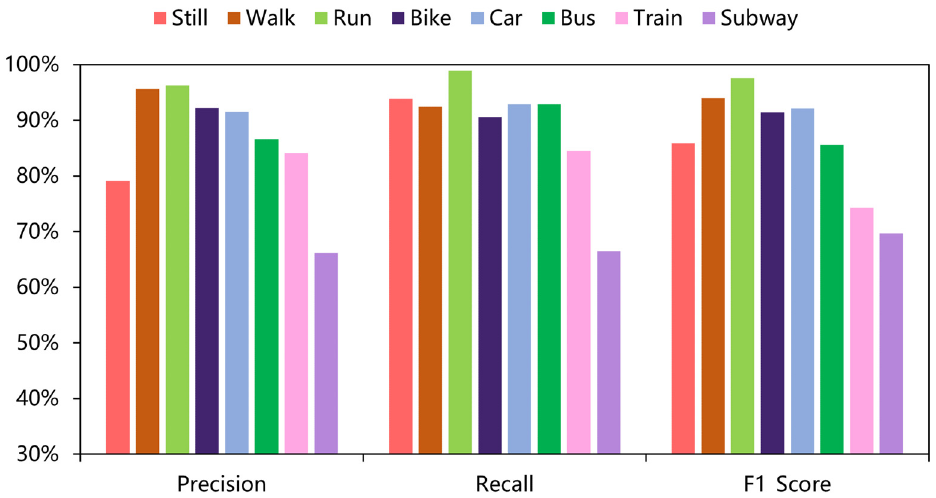
Figure 13. Performance evaluation results of the DFTrans model on the SHL dataset for eight clas- sifications.